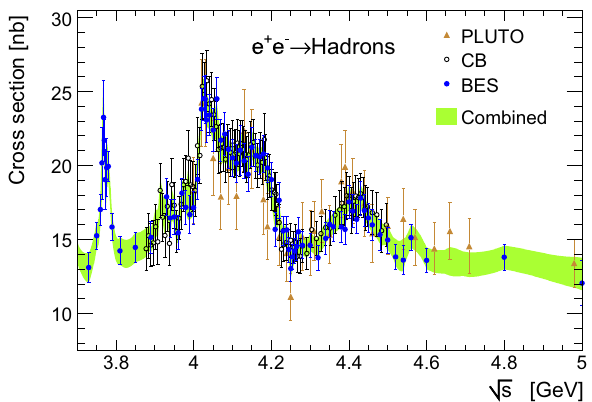
Fig. 8 Inclusive bare hadronic cross section versus centre-of-mass energyabovethe DD threshold.Theerrorbarsofthedatapointsinclude statistical and systematic uncertainties added in quadrature. The green band shows the HVPTools combination within its 1 σ uncertainty Ref. [55], which does not include HVP. Following